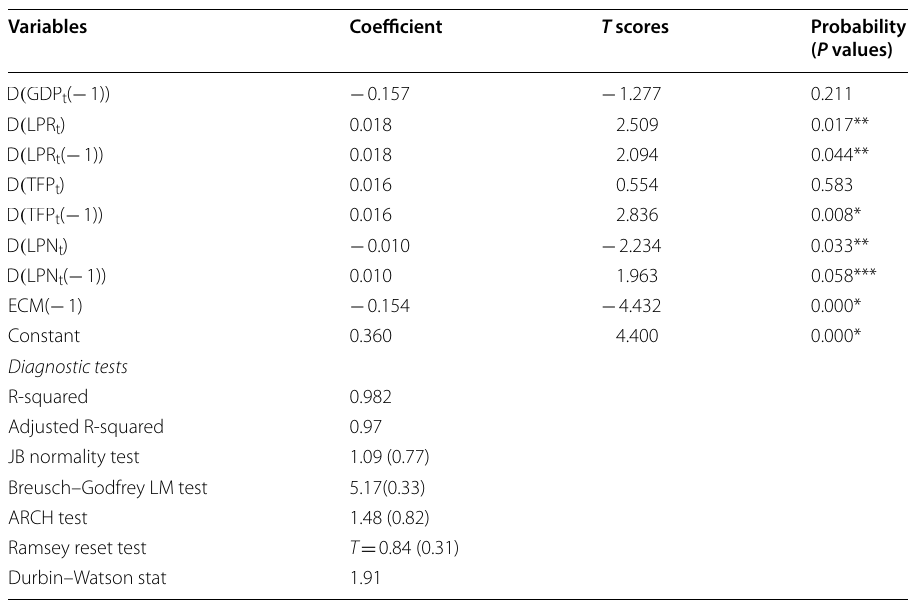
Table 8 Results of error correction